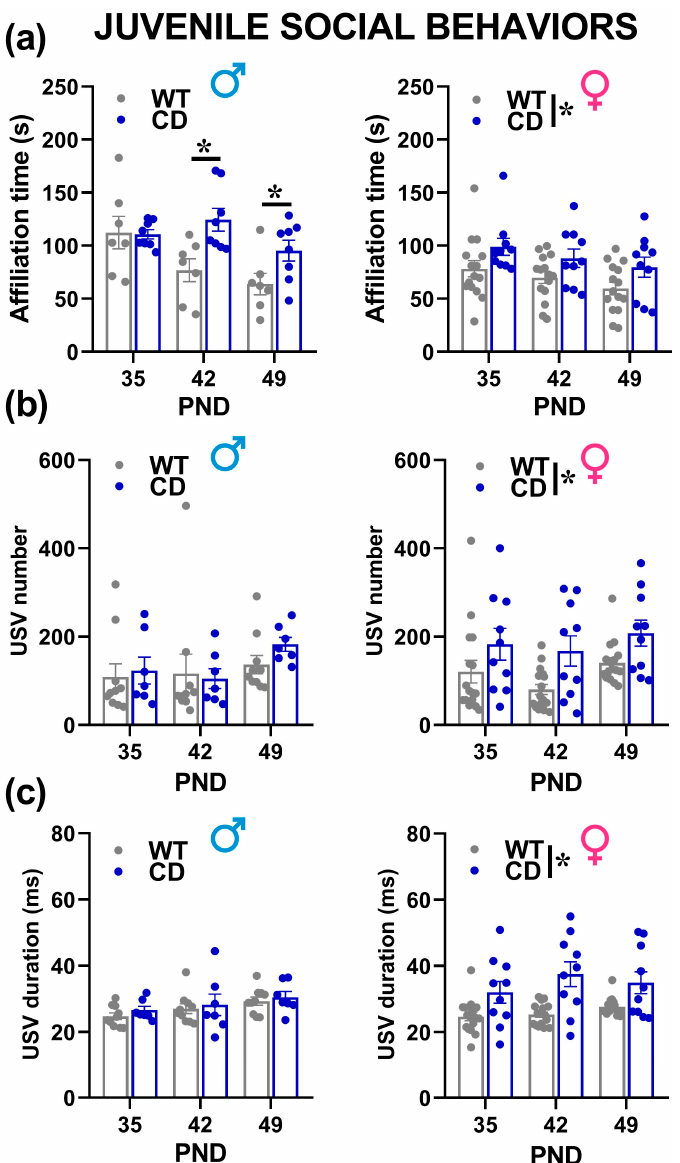
Figure 7. Social interaction and ultrasonic communication in juvenile mice. Affiliative behaviors ( a ), i.e., sniffing and exploring the stimulus mouse, were scored during three 6 min encounters with a conspecific of the same sex and age. Ultrasonic vocalizations (USVs) were analyzed both in their number ( b ) and mean duration ( c ). * = p < 0.05. Genotype differences emerged from ANOVA either from a main significant genotype effect (( a – c ) in females) or from a significant interaction genotype × testing day followed by pairwise comparisons (( a ) in males). Statistical analyses were conducted separately in males and females because different testing procedures were necessary to assess USVs in the two sexes. n = 15 males (7 WT, 8 CD) and 26 females (16 WT, 10 CD) for social interaction ( a ); n = 17 males (10 WT, 7 CD) and 26 females (16 WT, 10 CD) for USVs ( b , c ). • Assessment of female estrous cycle The estrous phase of juvenile CD and WT females was assessed by the analysis of vaginal smears [39] performed at the end of each testing day. The distribution of the estrous phases did not differ between genotypes on any considered day (Fisher exact test on PND 35, 42, 49, and 50, CD versus WT: n.s., Table